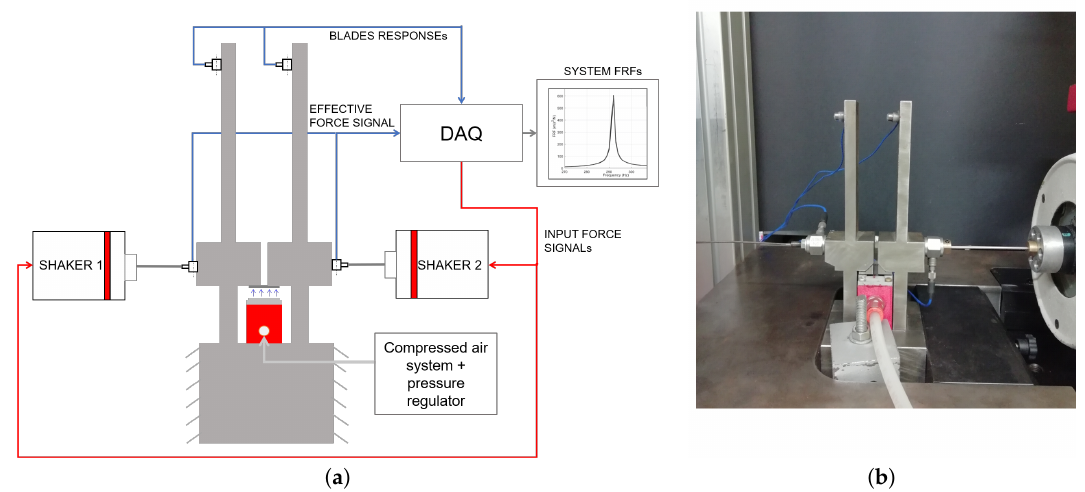
Figure 1. ( a ) test rig functional scheme; ( b ) photograph of the test